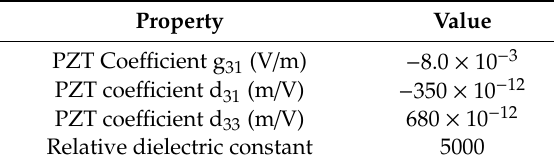
Table 6. PZT electro-mechanical